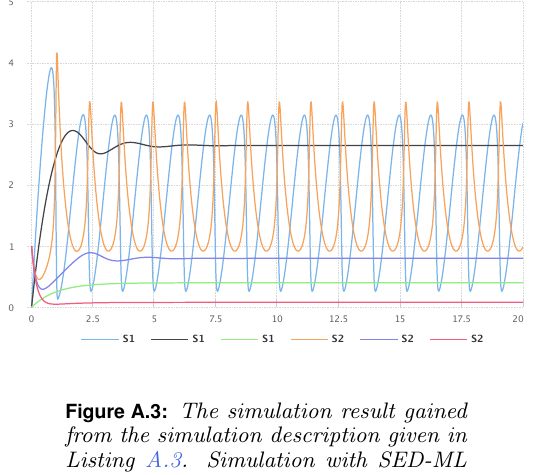
Figure A.3: The simulation result gained from the simulation description given in Listing A.3. Simulation with SED-ML web tools [2].